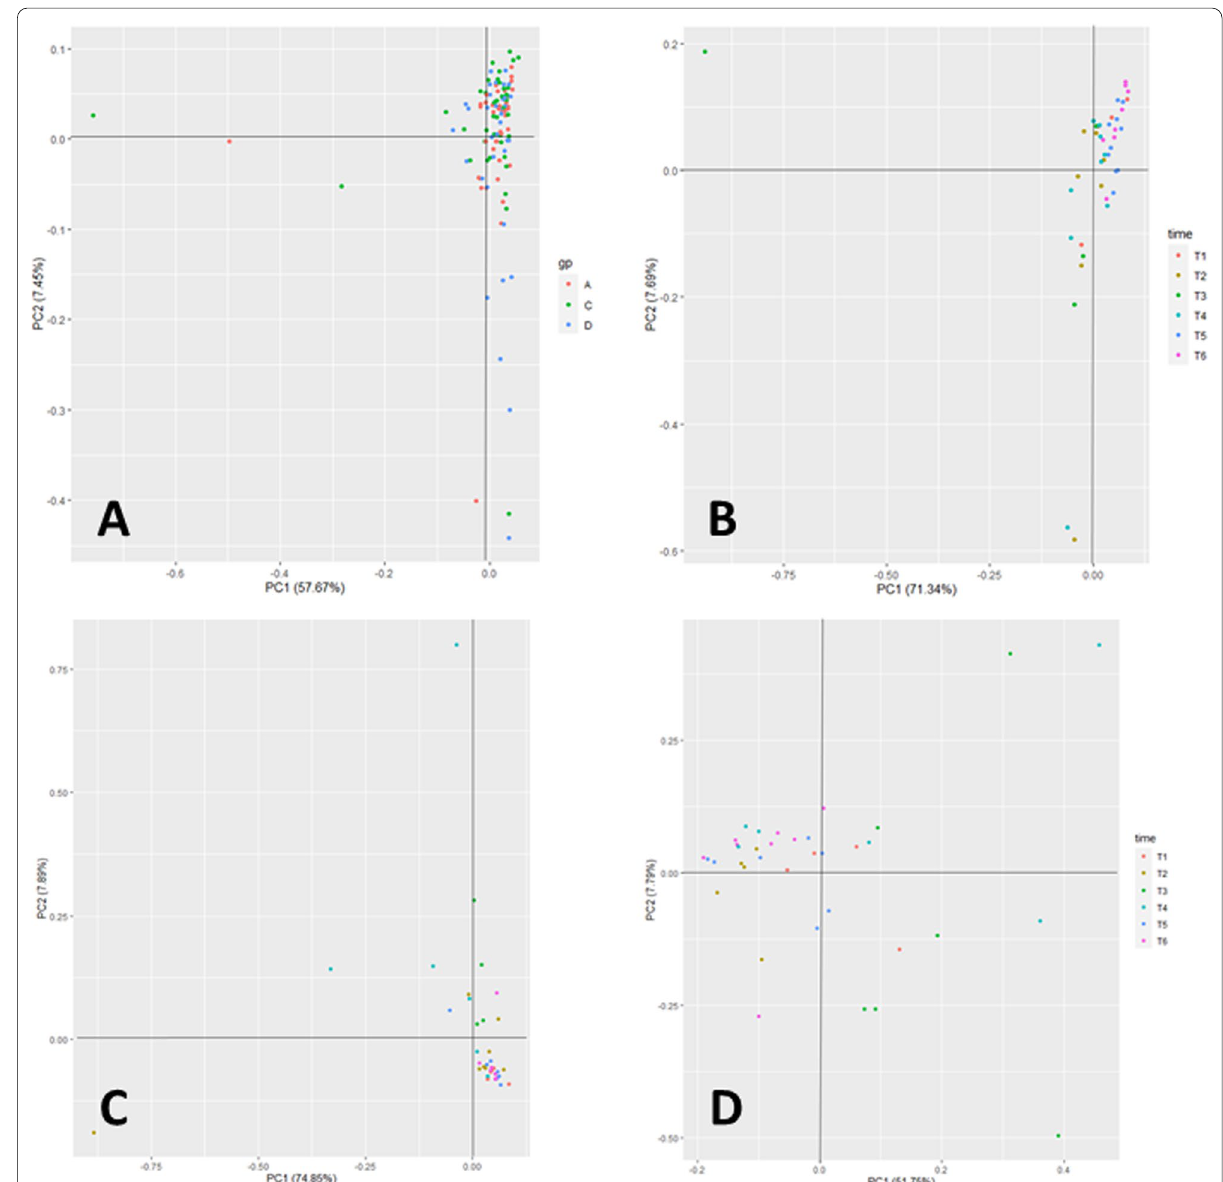
Fig. 3 PCA‑based visualization of microbial taxonomic profiles generated from the URT of beef calves. A All calves together comparing the effect of stressors independent of sampling point (ANOSIM R 0.009; p 0.18). B Suckling calves comparing sampling time (ANOSIM R = = C Weaned calves comparing sampling time (ANOSIM R 0.1337; p 0.006). D Weaned Transport calves comparing sampling time (ANOSIM = = + R 0.3418; p 1e‑04). ANOSIM‑R 0–0.25—highly overlapped; ANOSIM‑R 0.25–0.5‑ different with some overlap; ANOSIM‑R = = = = less overlap; ANOSIM‑R 0.75‑ different. p ‑value indicates probability of ≥